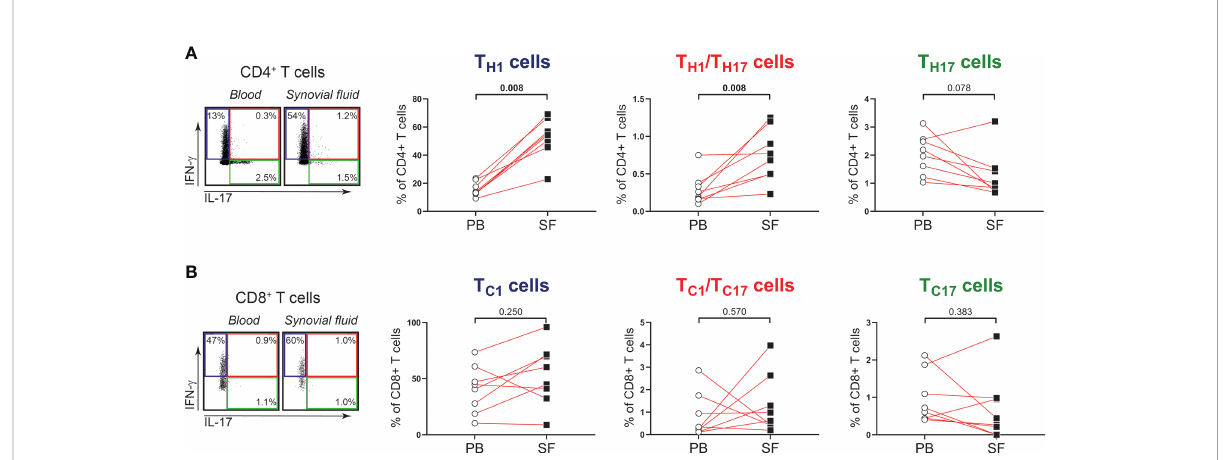
FIGURE 4 IFN- g and IL-17 production by T cells in synovial fl uid of patients with PMR. (A) Representative fl ow cytometric staining (left panel) and percentages (right panels) of CD4 + IFN- g + IL-17 - (T H1 ), CD4 + IFN- g + IL-17 + (T H1 /T H17 ) and CD4 + IFN- g - IL-17 + (T H17 ) T cells, and (B) CD8 + IFN- g + IL-17 - (T C1 ), CD8 + IFN- g + IL-17 + (T C1 /T C17 ) and CD8 + IFN- g - IL-17 + (T C17 ) T cells in peripheral blood (PB) and synovial fl uid (SF) of 8 patients with PMR. Statistical signi fi cance by Wilcoxon signed rank test is